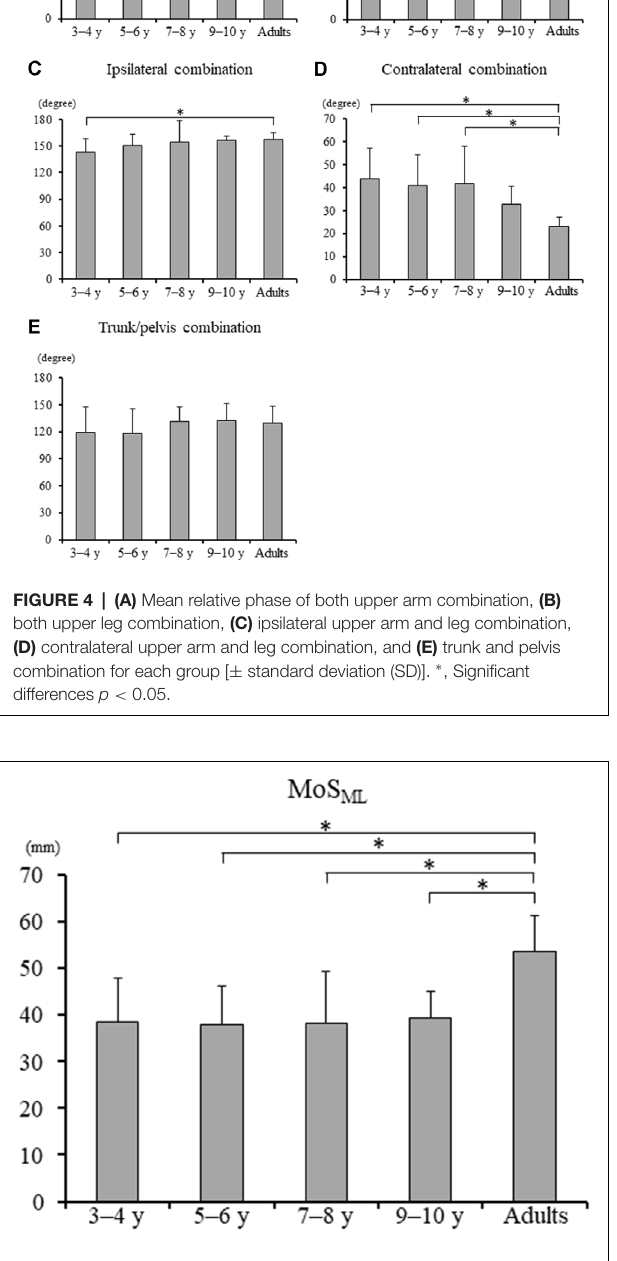
during gait (MoS ML ) was not fully mature at age 10.